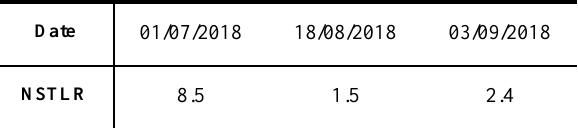
Table 1. NSTLR value based on LST-DEM feature space for different dates (  C Km -1